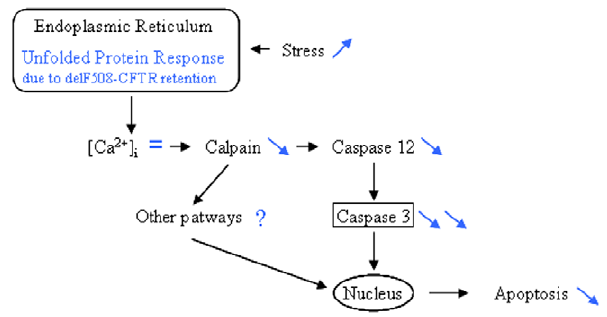
Figure 6. Schematic presentation of molecular mechanisms involving calpains and caspases leading to apoptosis in F508del-CFTR expressing cells. This schematic representation is adaptated from [27]. Black arrows indicate the pathway in CFTR expressing cells. In dark grey are our proposed modifications in F508del-CFTR expressing